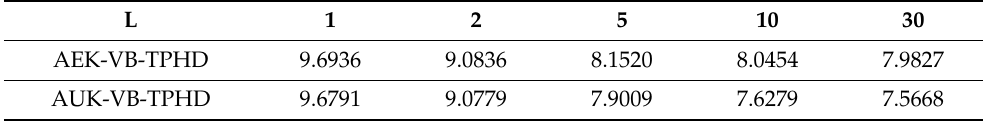
Table 4. The RMS TM error of the AEK-VB-TPHD and AUK-VB-TPHD